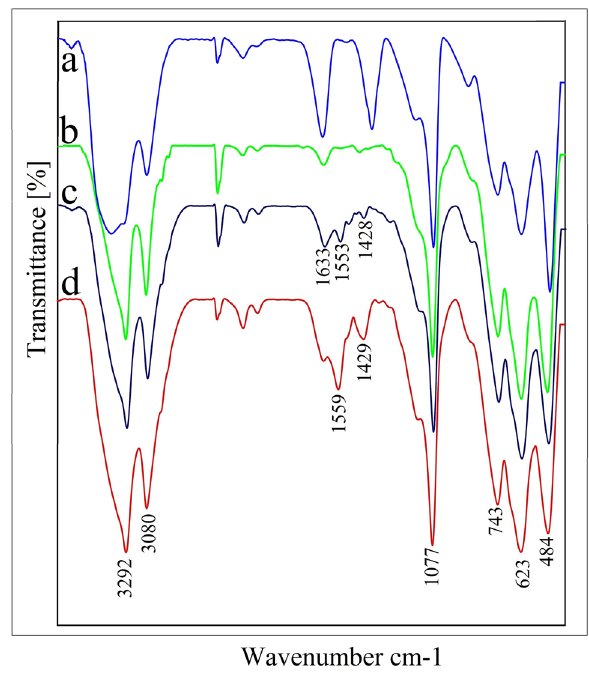
Figure 10. FT-IR spectra of ( a ) boehmite, ( b ) boehmite@CPTMS, ( c ) bis(PYT)@boehmite and ( d ) Sm-bis(PYT)@boehmite.